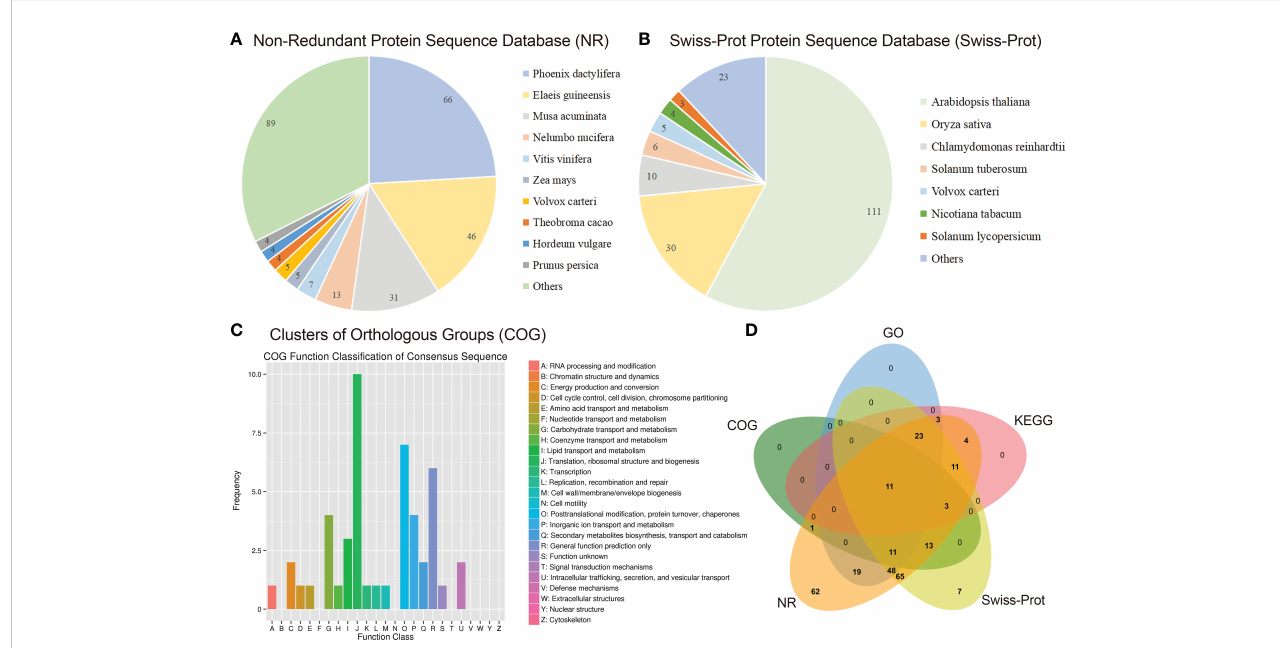
FIGURE 4 Homology search of the transcriptome-derived 359 unigenes of the three varieties, of Florex gold (FG), Rehmannii (RE) and Black Magic (BM) against NR, Swiss-Prot and COG database. The distribution of homologous species with signicant hit in NR (A) and Swiss-Prot (B) . (C) COG function classi fi cation of above consensus unigenes. (D) Venn diagram shows the functional annotation of FG-RE-YN consensus unigenes.